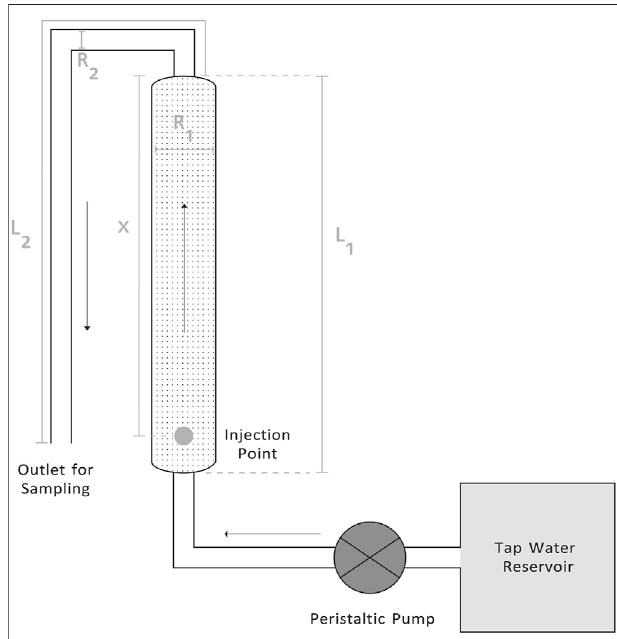
FIGURE 4 | Experimental setup for the fl uorescent tracer tests.